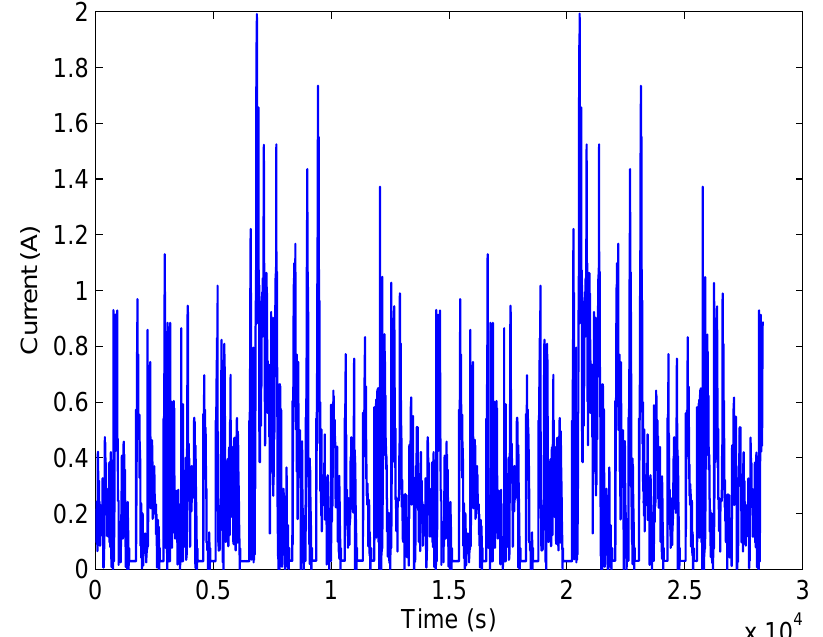
Figure 10. Current profiles in the urban dynamometer driving schedule (UDDS) test.